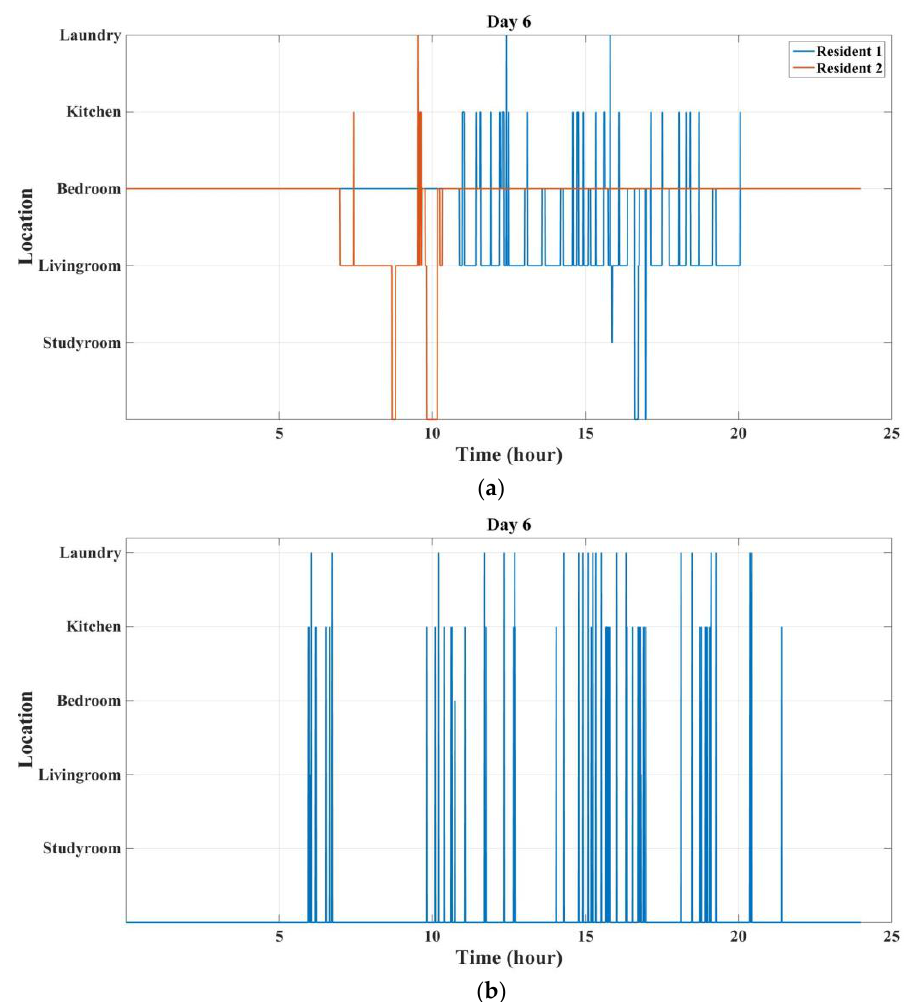
Figure 14. Localization and activity labelling for the sixth day: ( a ) Location of the resident; ( b ) Non-labelled sensor events.